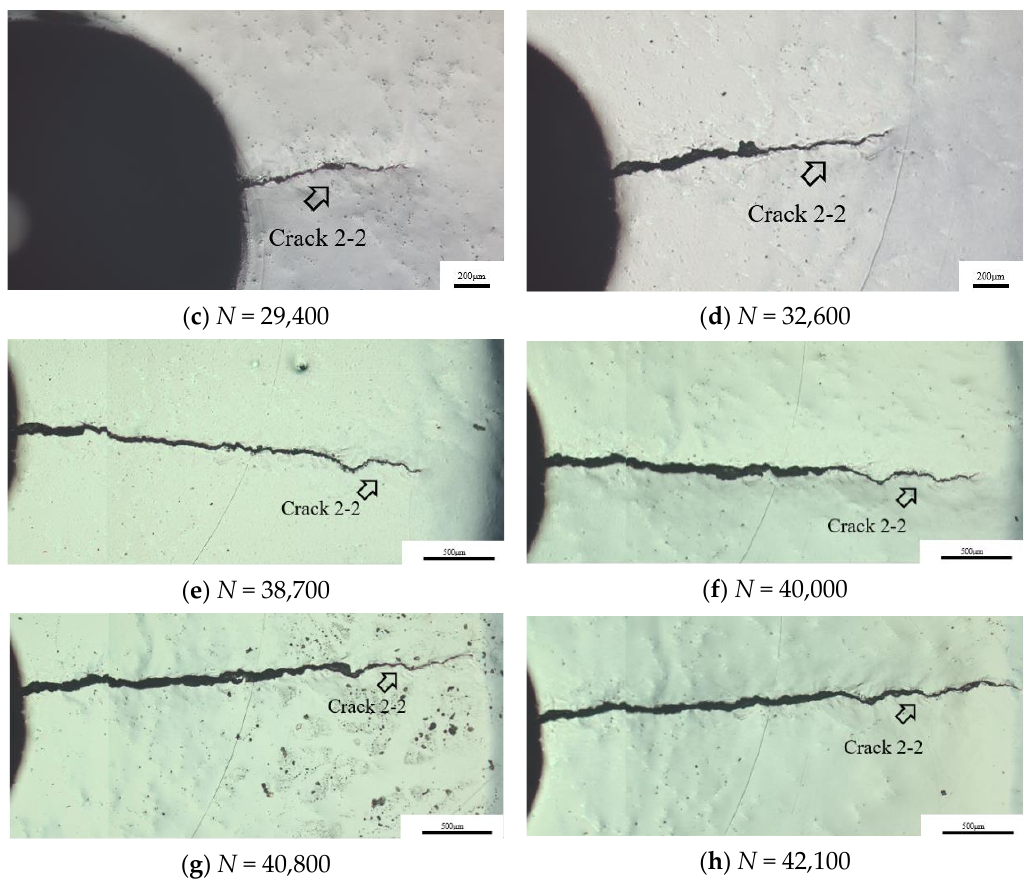
Figure 11. Crack 2-2 initiation and propagation process.